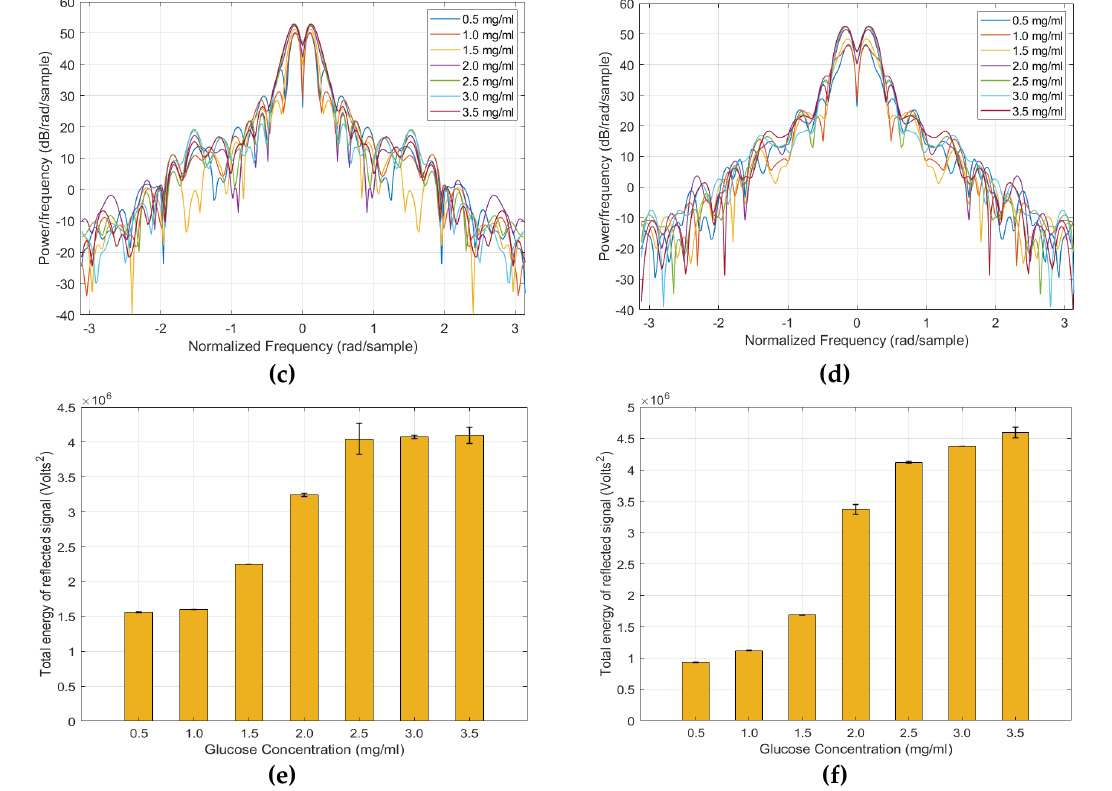
Figure 10. Raw data analysis ( a ) DFT result for data in channel 1 (enclosed plot is for the spectrum when shifted to the center); ( b ) DFT result for data in channel 2 (enclosed plot is for the spectrum when shifted to the center); ( c ) power spectral density estimation for data in channel 1; ( d ) power spectral density estimation for data in channel 2; ( e ) resultant energy for glucose concentrations in channel 1; ( f ) resultant energy for glucose concentrations in channel 2.